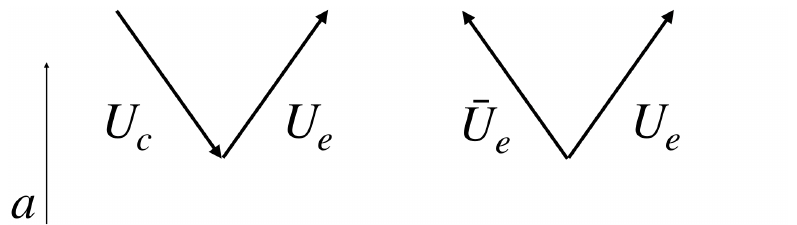
Figure 16. A contracting and an expanding universe, both made of matter, can also be seen as a pair of expanding universes, one of them made up of matter and the other made up of antimatter, i.e., they can be seen as a universe–antiuniverse